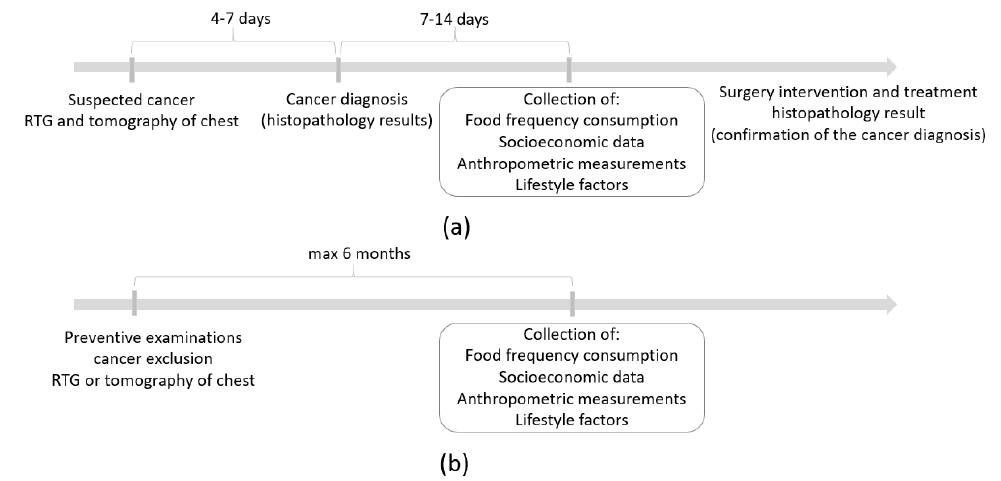
Figure 1. Time schemes of the study design for ( a ) the cancer sample and ( b ) the control sample. RTG digital X-ray examination.